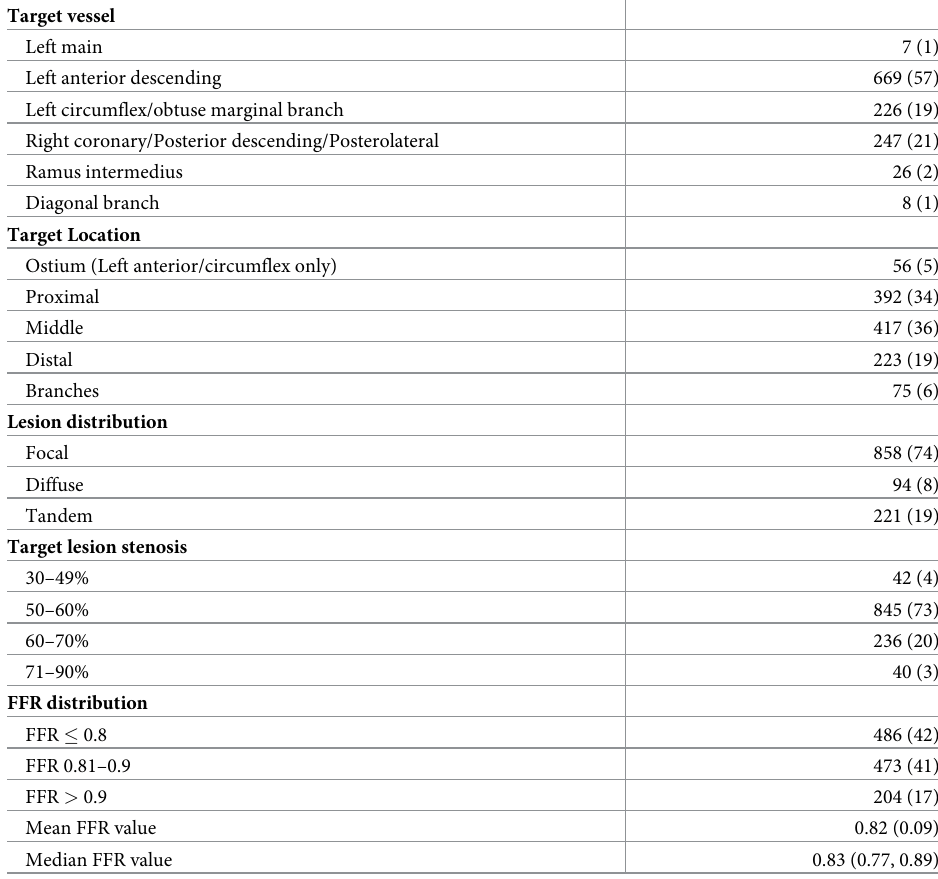
Table 2. Characteristic of the target